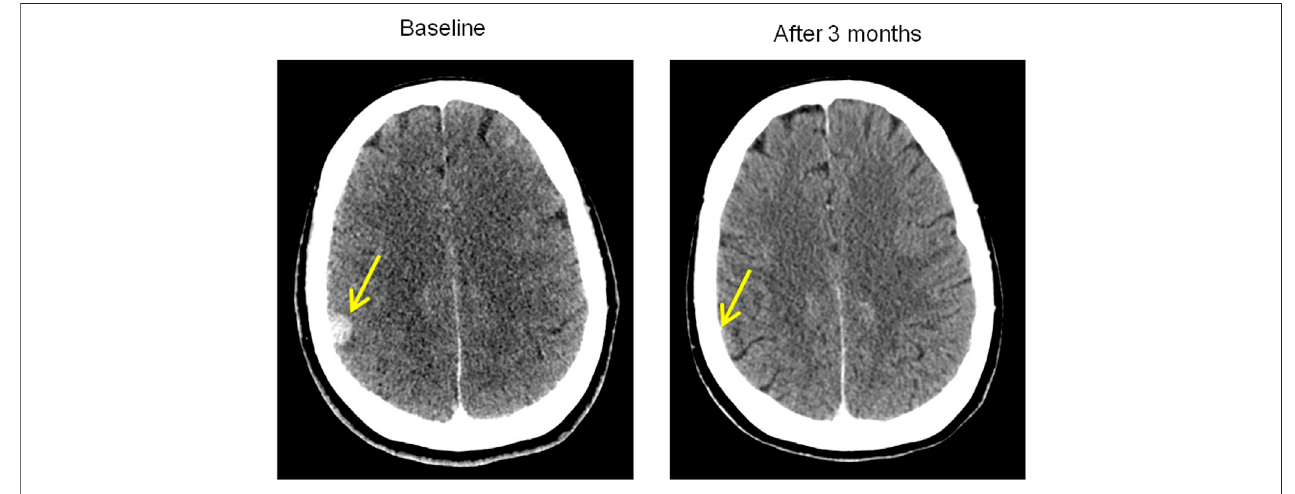
FIGURE 3 | Brain response at CT scan. Comparison between baseline brain lesion at diagnosis and the impressive complete response after 3 months following chemoimmunotherapy and osimertinib. Osimertinib was only taken for a total of 37 days and then suspended because of severe toxicity.